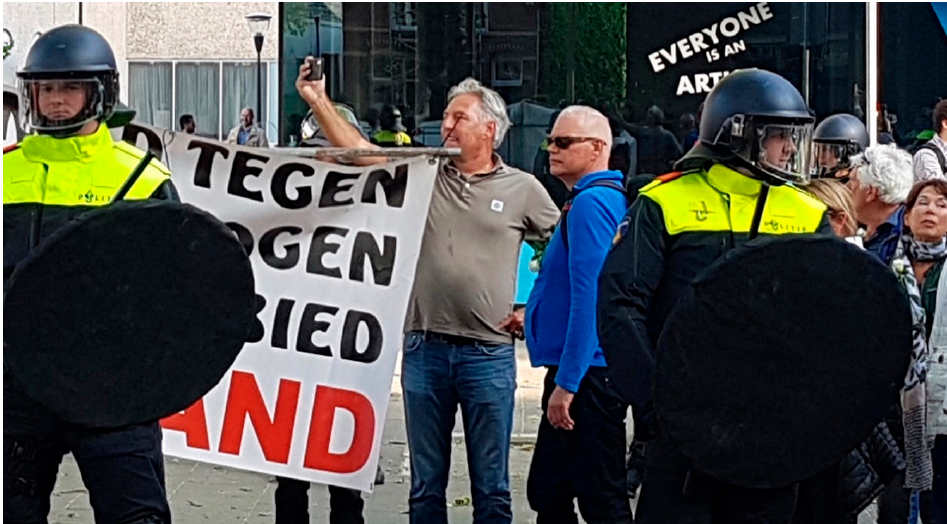
Figure 1. Pegida leader Edwin Wagensveld filming the counter-protesters while preparing for the march. Photo taken by the author.